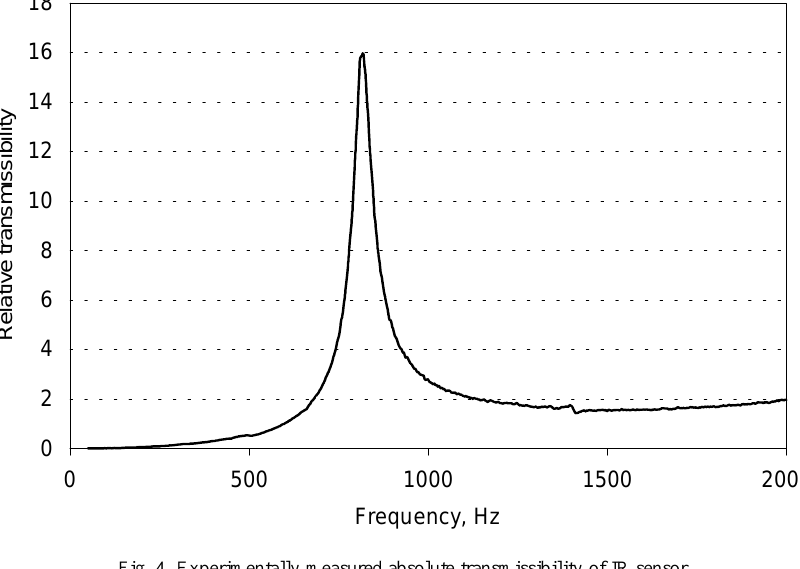
Fig. 4. Experimentally measured absolute transmissibility of IR sensor.